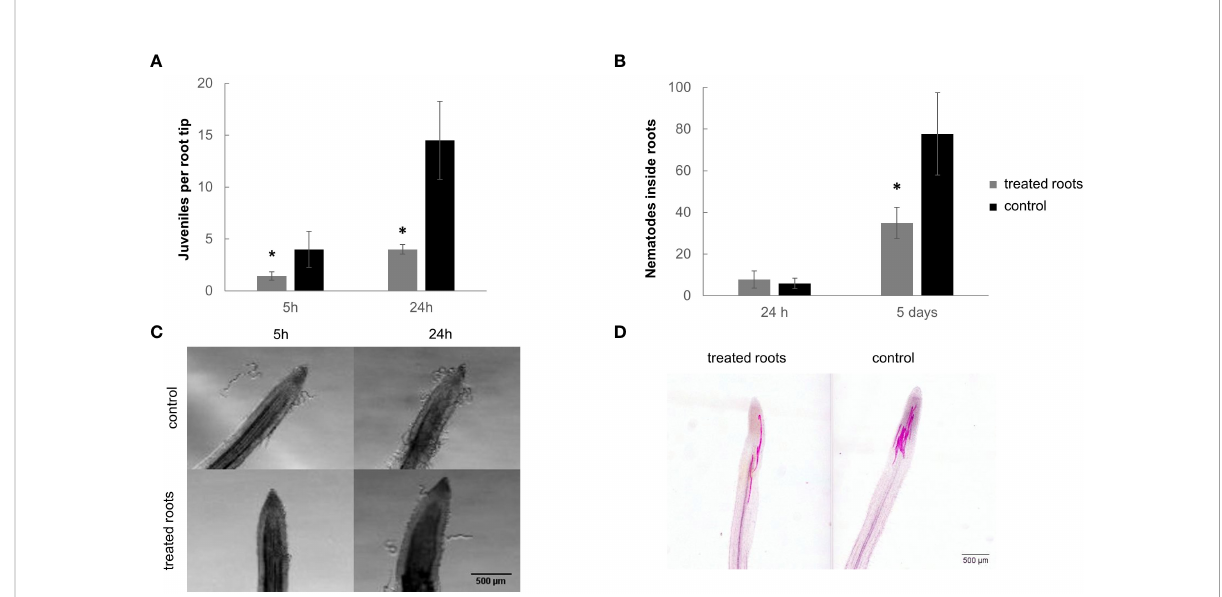
FIGURE 3 M. incognita juvenile attraction and penetration in tomato roots treated with the dual bacteria combination. (A) Number of juveniles around root tip at 5 hai and 24 hai. (B) Number of nematodes inside the roots at 24 hai and 5 dai. (C) A representative image of a tomato root tip surrounded by J2 from M. incognita . (D) A representative image of J2 after penetration on a tomato root tip. 600 juveniles were inoculated per plate. Roots were submerged in a suspension of 1 x 10E+06 CFU/ml of the dual-strain bacteria combination of B paralicheniformis FMCH001 and B subtilis